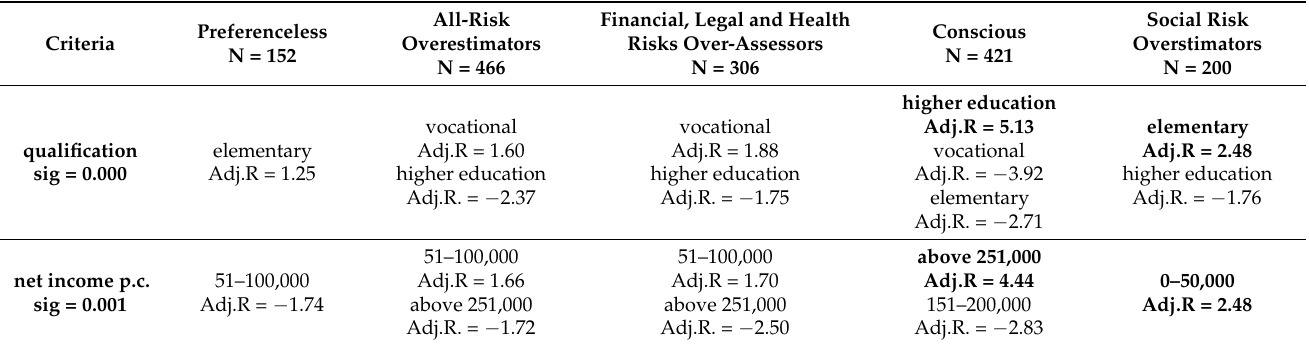
Table 8. Socio-demographic characteristics of investor segments by perceived risk